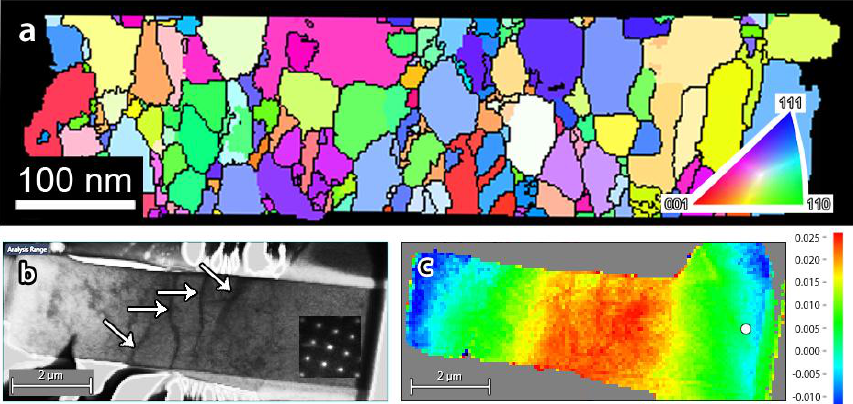
Figure 9. ( a ) Example of ACOM-TEM on a nanocrystalline Pd thin film. The colour code inverse pole figure is shown in the inset; ( b , c ) a virtual BF image and the corresponding local strain field map of a fatigued single-crystal Ni micropillar with dislocation walls seen as black curved lines running between opposite sides and are highlighted with white arrows.